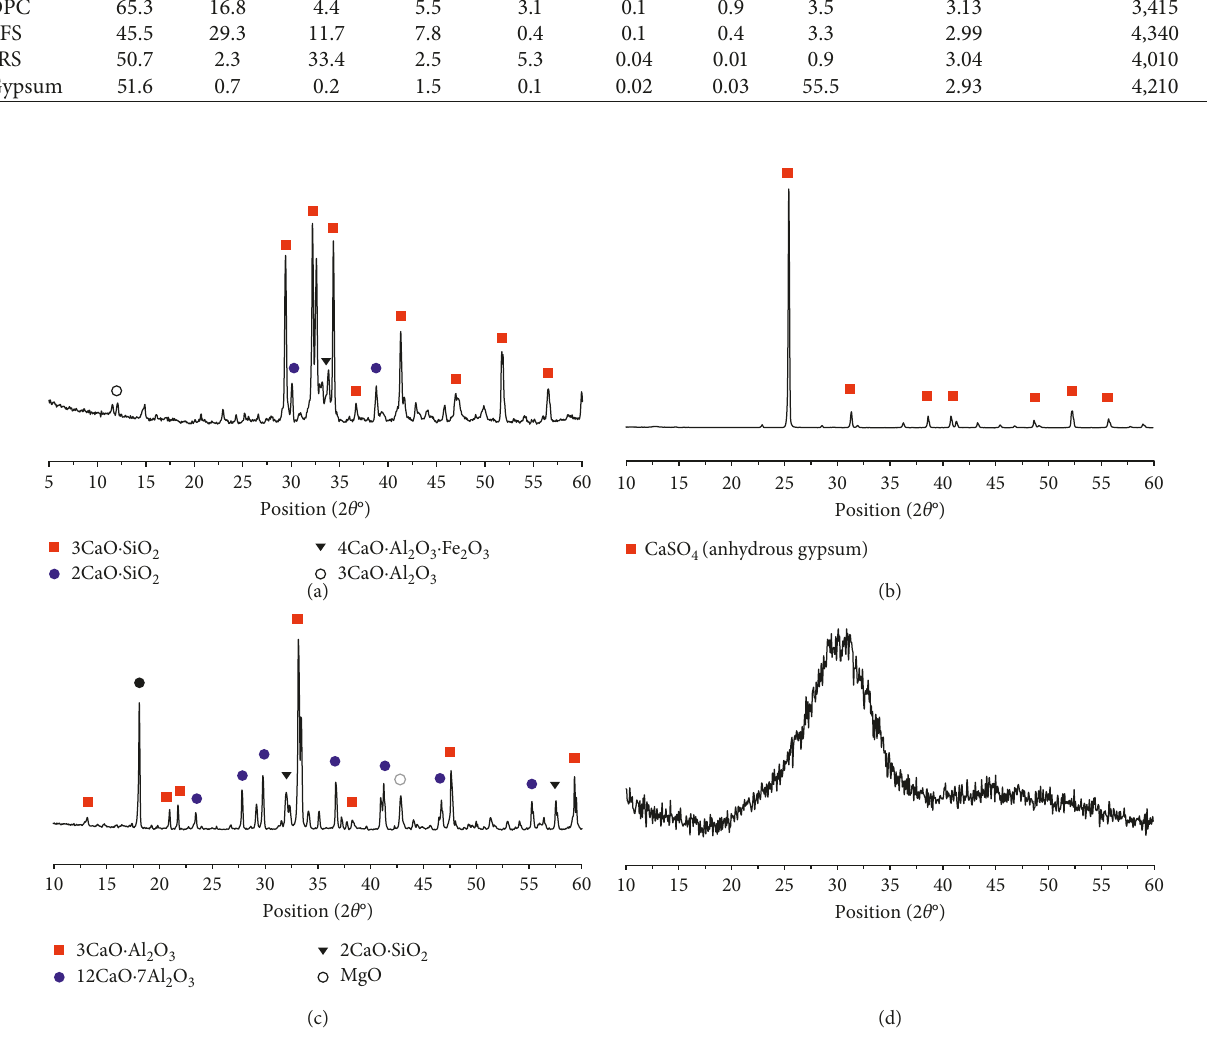
Figure 2: XRD spectra of the test materials. (a) OPC. (b) Gypsum. (c) SRS. (d)